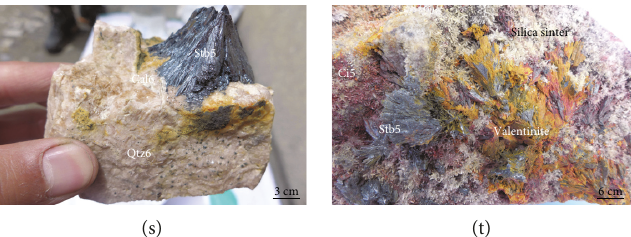
Figure 4: Hand specimen photographs of representative samples from the Keyue Sb – Pb – Zn – Ag deposit. (a) Assemblage 1 lamellar sphalerite – pyrite – arsenopyrite and assemblage 2 massive and banded sphalerite – pyrite – galena hosted by Mn – Fe carbonate. (b) Assemblage 1 lamellar sphalerite – pyrite – arsenopyrite hosted by Mn – Fe carbonate, later assemblage 4 quartz – boulangerite veins cut the Mn – Fe carbonate; this sample also contains massive assemblage 4 quartz – boulangerite. (c) Assemblage 1 disseminated pyrite and chalcopyrite hosted by assemblage 1 Mn – Fe carbonate, later assemblage 4 quartz – boulangerite veins cut the Mn – Fe carbonate. (d) Banded assemblage 2 Mn – Fe carbonate – sphalerite – pyrite ore that contains some assemblage 3 quartz. (e) Massive assemblage 2 Mn –